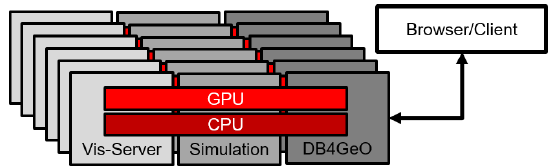
Figure 2. New object-model in DB4GeO (follows OGC’s General Feature Model)